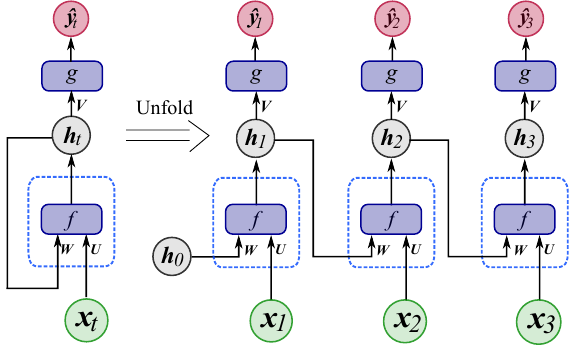
Figure 1. Many-to-many basic RNN.